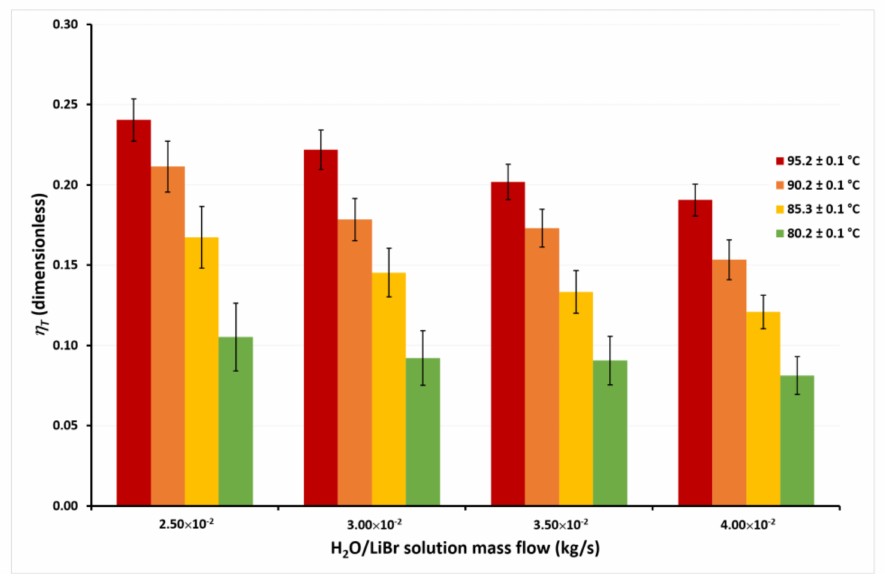
Figure 9. Thermal energy efficiency as a function of the ˙m LiBr with T cw,in = 45.1 ± 0.1 ◦ C.